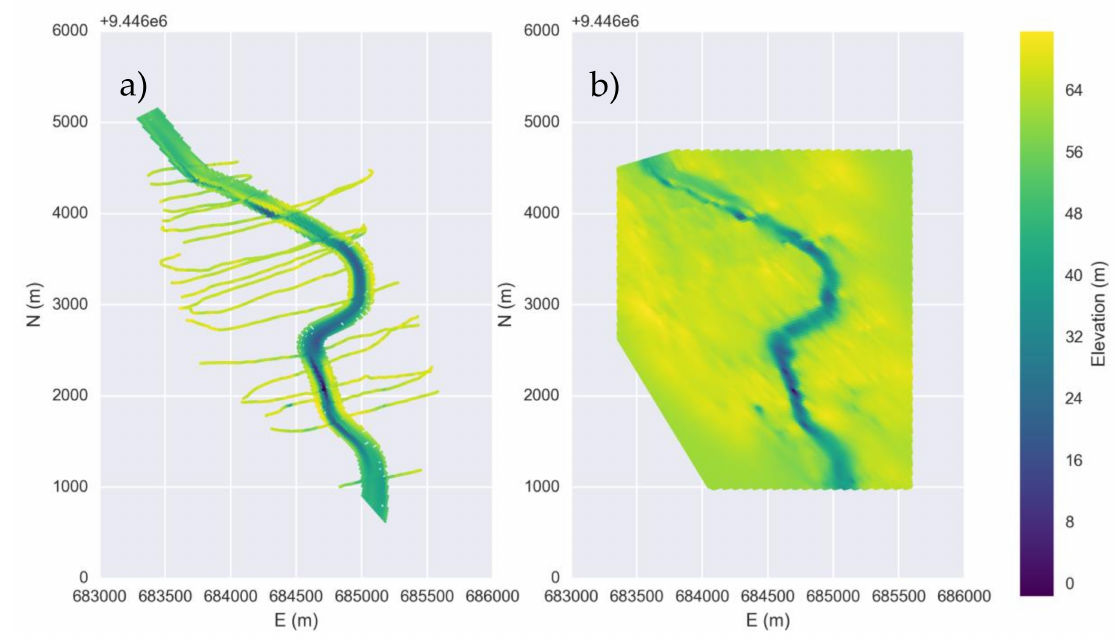
Figure A2. ( a ) All the Bathymetry data and the results from the first step at the coordinate system grid (E-N) were used as an input for the second step; ( b ) Bathymetry results from kriging interpolation after the second